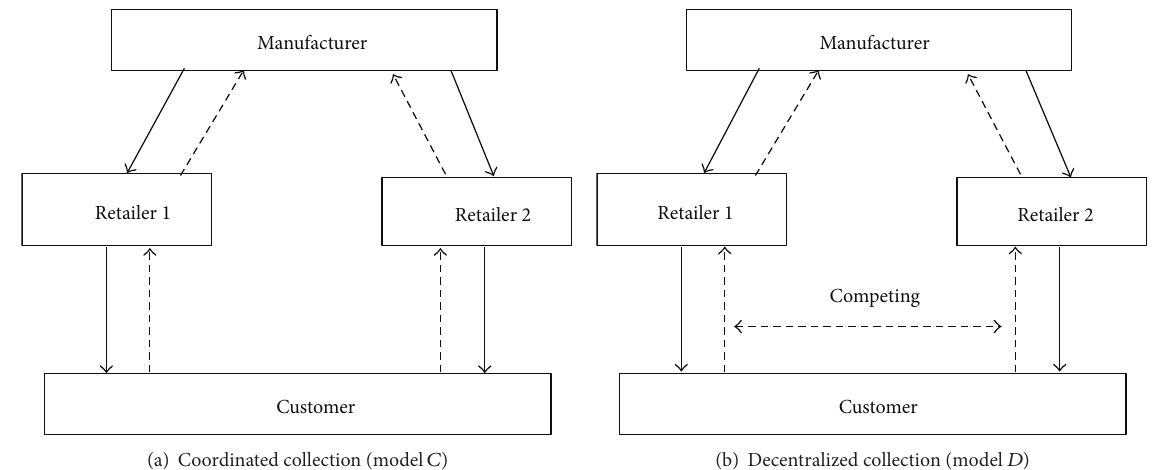
Figure 1: Closed-loop supply channel